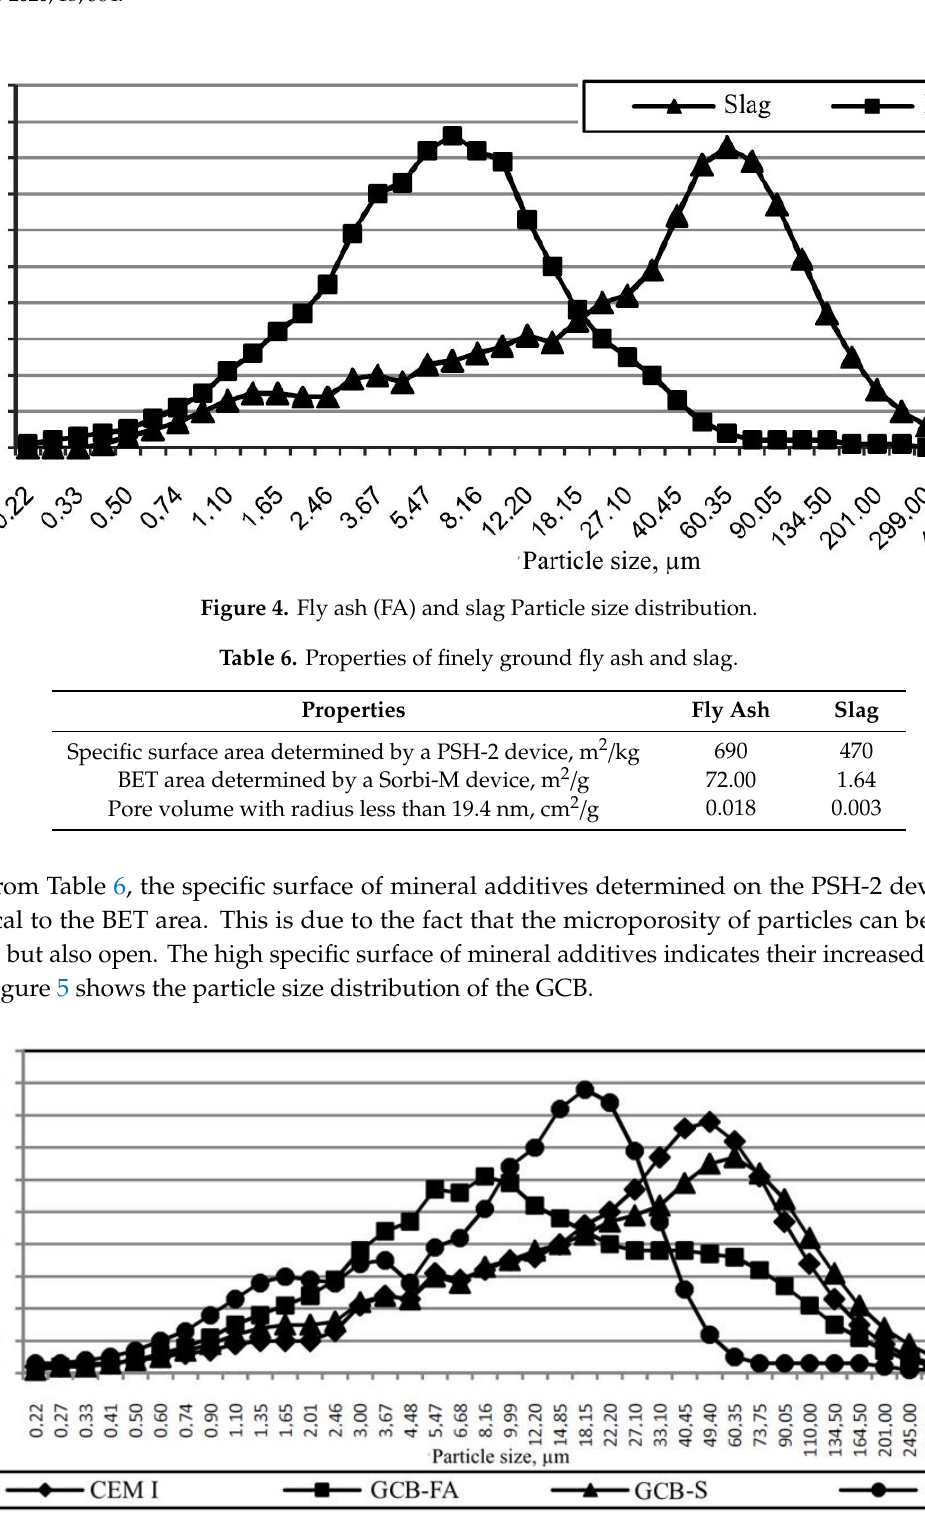
Figure 5. Particle size distribution of the GCB.